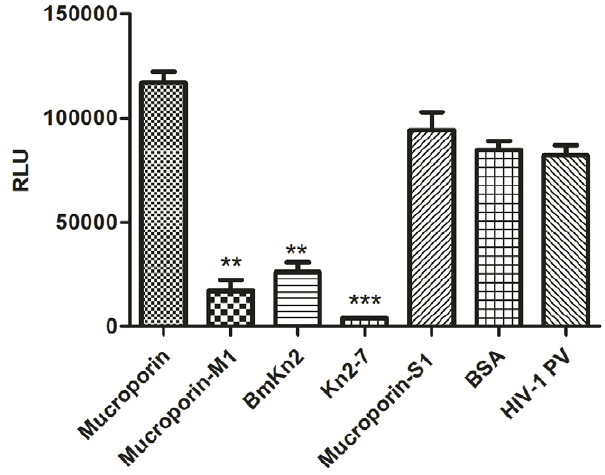
Figure 1. Kn2-7 was the most effective peptide against HIV-1 PV by screening assay. The antiviral effect of the peptides against HIV-1 PV was performed by TZM-bl detection systems as described in Materials and Methods. Briefly, 10 m g/ml of peptides were incubated with 200 TCID 50 of HIV-1 PV for 1 h at 37 u C and then added to TZM-bl cells. The luciferase activity was measured in a 96-well black solid plate by Turner Biosystems Modulus II microplate reader 48 h later. Significant reduction in the RLU value of groups treated by different peptides compared to virus group in which cells were exposed to BSA are denoted by a * (p , 0.05), ** (p , 0.01), and *** (p , 0.001). Data are expressed as mean 6 SD of three replicate samples.